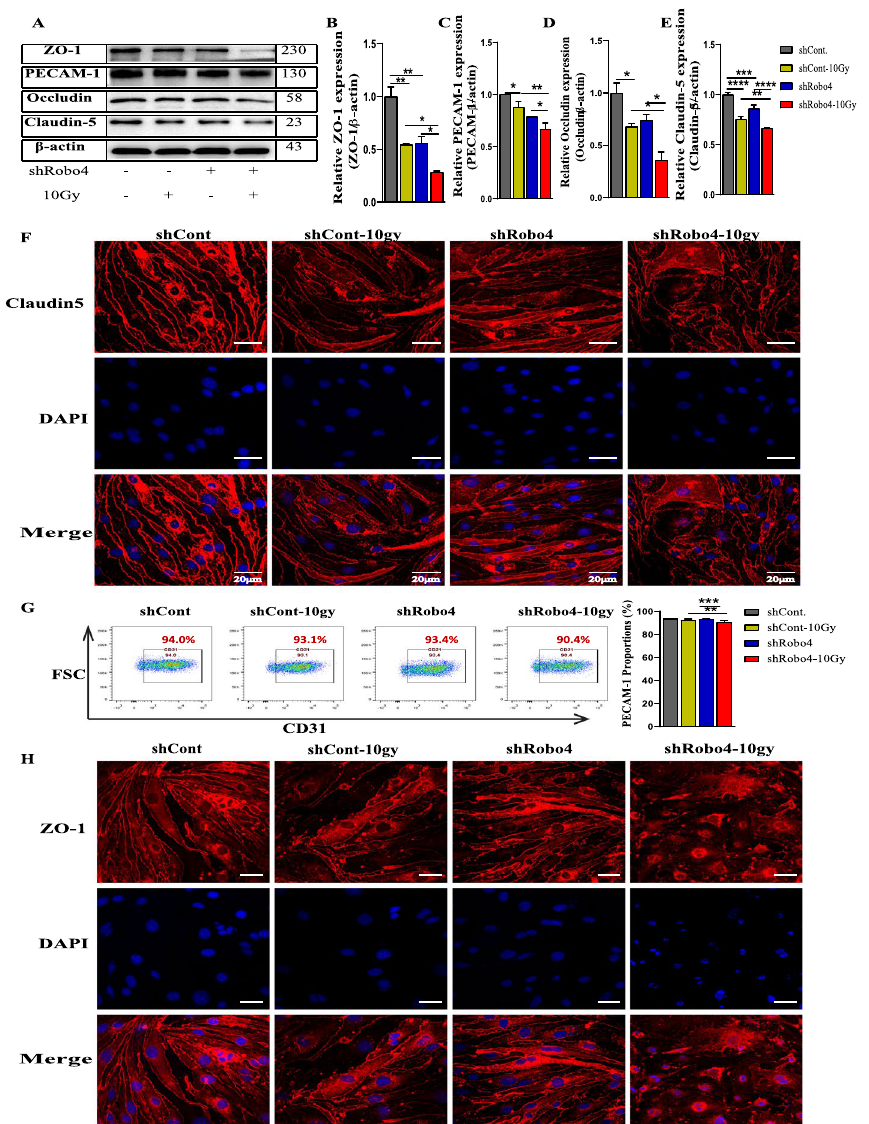
Fig. 3 Robo4 silencing degrades the expression and organization of TJ molecules after γ-radiation exposure. A–E Western blotting analysis of claudin-5, occludin, PECAM-1, and ZO-1 normalized with endogenous beta-actin protein. The relative protein expression were quantified using Image J software. F Immunostaining for claudin-5 (red) and DAPI staining (blue) in irradiated Robo4 knockdown and control microvascular EC samples. G Flow cytometric analysis of PECAM-1 expression levels after Robo4 knockdown and irradiation. H Confocal imaging of ZO-1 (red) and DAPI (blue) in Robo4 silenced and controlled ECs with or without gamma radiation exposure. Scale bars 20 µm. For all experiments, n 3, and error bars represent std. * P < 0.05, = ≥ ** P < 0.01, *** P < 0.001, **** P <